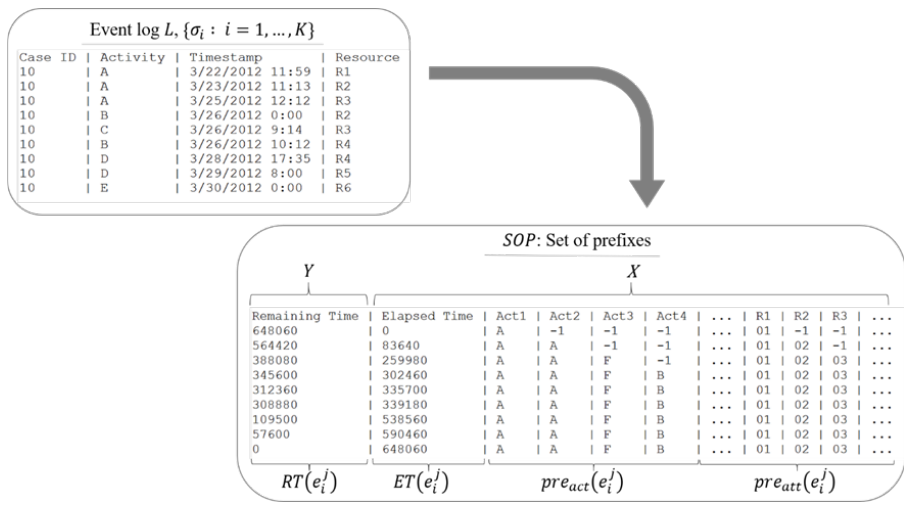
Figure 3. Conversion of the event log to set of prefixes (SOP).